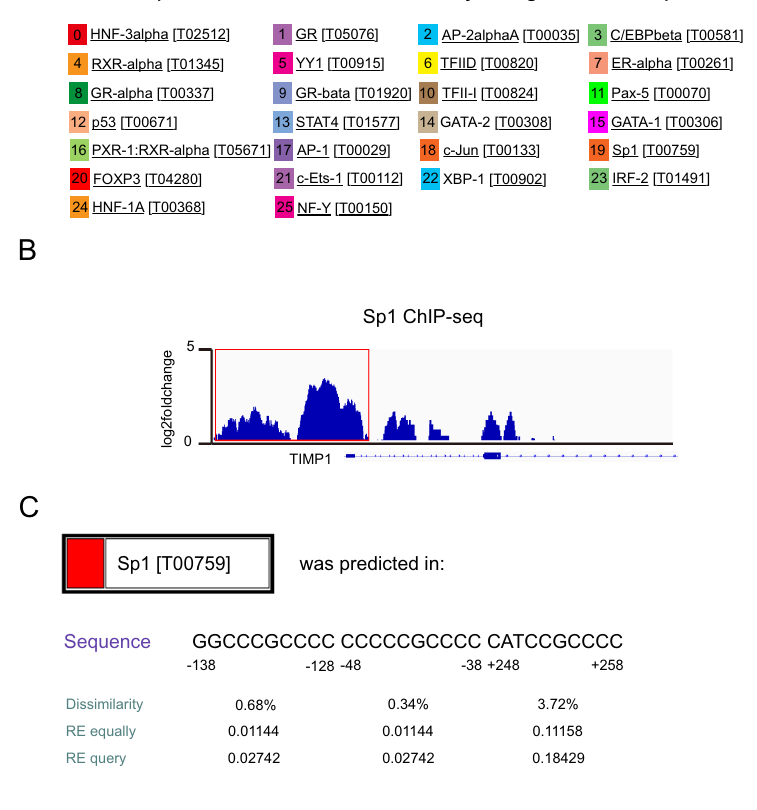
Figure 6. Identifying transcriptional factors of TIMP1. ( A ) Prediction of the upstream transcriptional factor of TIMP1 in PROMO database (maximum matrix dissimilarity rate—0.5). ( B ) Sp1 ChIP-seq peak of TIMP1 promoter region from GEO database (GSE92217). The signal in the red rectangle indicates Sp1 interacts with the promoter region of TIMP1. ( C ) Prediction binding sites between Sp1 and TIMP1 promoter (−2000 bp to + 1000 bp) by PROMO database. Binding sites 1, −138 bp to −128 bp; Binding sites 2, −48 bp to −38 bp; Binding sites 3, + 248 bp to + 258